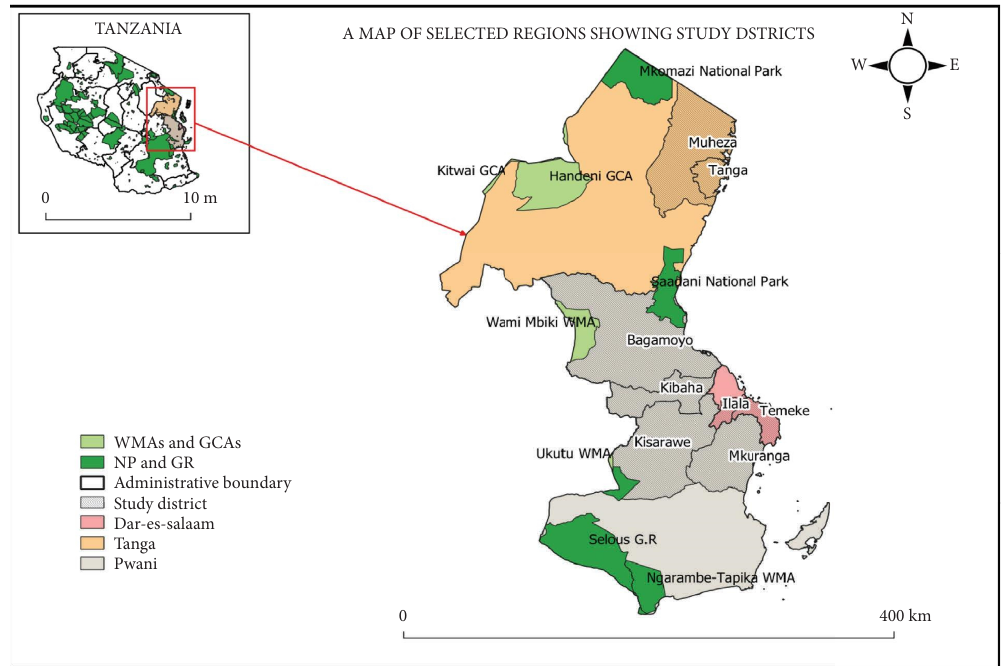
Figure 2: A map showing study districts in the eastern coast zone of Tanzania which are bordering national parks, forest reserves, or wildlife management areas. Te districts were selected for the study of the seroprevalence and risk factors of brucellosis in commercial cattle